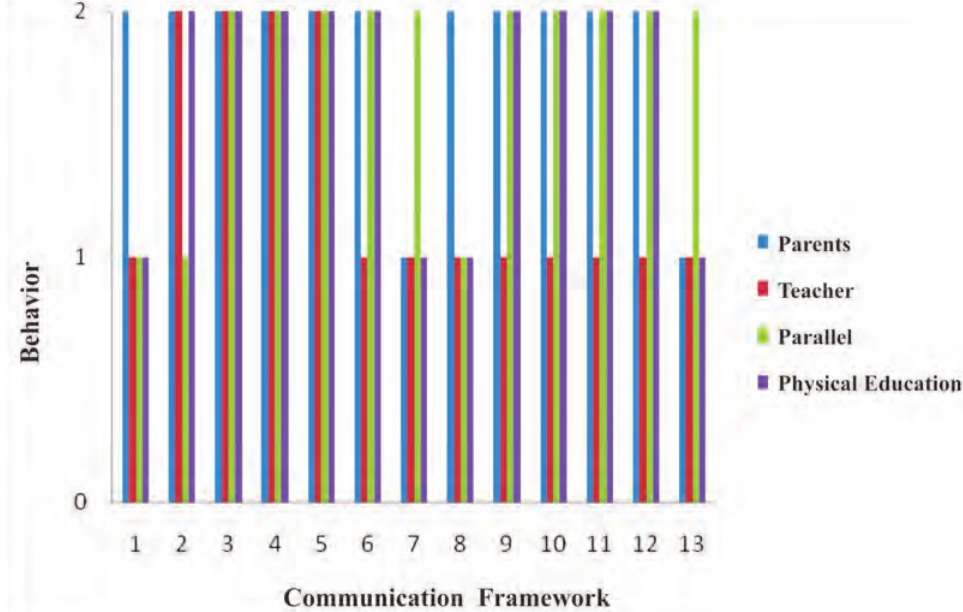
Figure 3. Communication